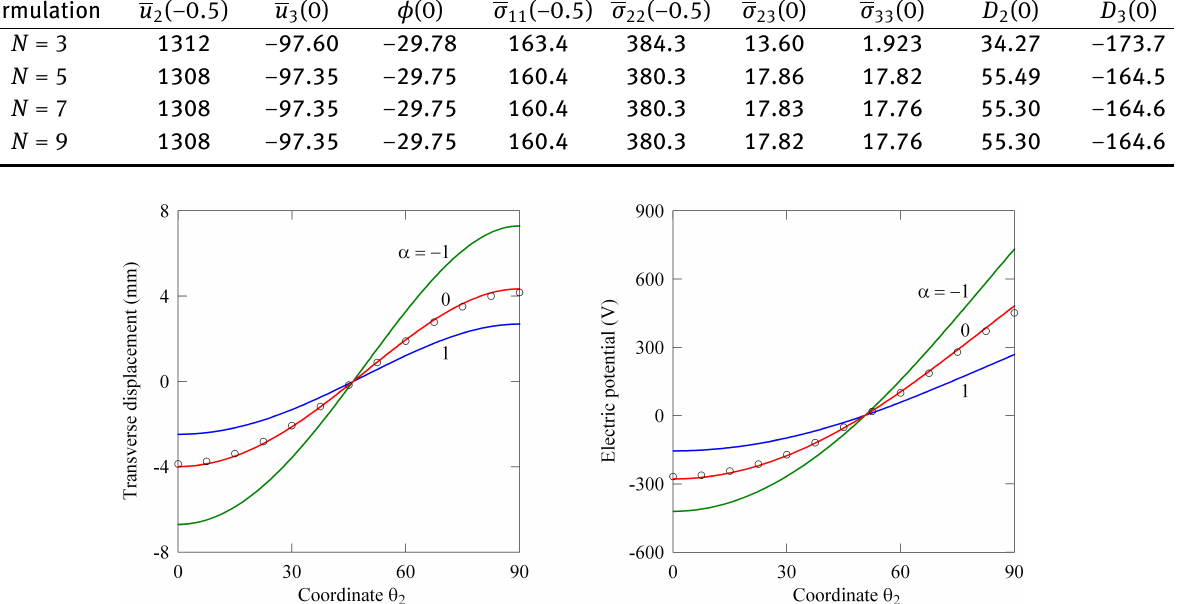
Figure 12: Distribution of the transverse displacement of the bottom surface u 3 (0, θ 2 , −0.5) and the electric potential of the middle surface ϕ (0, θ 2 , 0) in section AB for a thin cylindrical shell along coordinate θ 2 ; GeXSaS4 element (—) using five SaS and isoparametric layer-wise shell element [50] for α = 0 ( ∘ ).